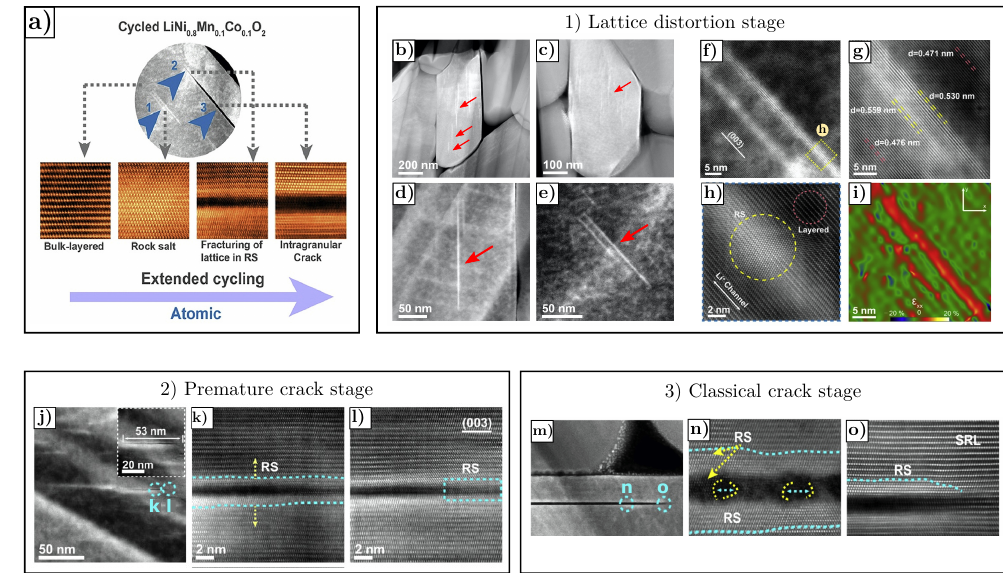
Figure 23. ( a ) Development process of intragranular cracks in NMC811: ( b – i ) Lattice distortion stage, ( j – l ) Premature crack stage and ( m – o ) Classical crack stage. STEM-HAADF images of cycled NMC811 particle in <010> zone projection, after ( b – d ) 50 cycles and ( c – e ) 20 cycles. The white lines appear with different length. ( f ) STEM-HAADF image of enlarged morphology of a white line shown in ( a ). ( g ) High-resolution STEM-HAADF image, showing the lattice distortion of the white line region. ( h ) Atomic-resolution STEM-HAADF image from the region marked by yellow dashed square box in ( f ), showing the detailed structure of the white line, with the formation of the rock-salt phase. ( i ) Strain map simulated by GPA due to lattice distortion. ( j – l ) Atomic-resolution STEM-HAADF images of premature intragranular crack in NMC811 particle after 50 cycles, showing the presence of the rock-salt phase both in the ( k ) partially cracked region and ( l ) uncracked tip. ( m – o ) Atomic-resolution STEM-HAADF images of mature intragranular crack in NMC811 particle after 100 cycles, showing the increase in the crack length along the (003) plane and in the rock-salt phase thickness. Reprinted with permission from Elsevier by [111], Copyright